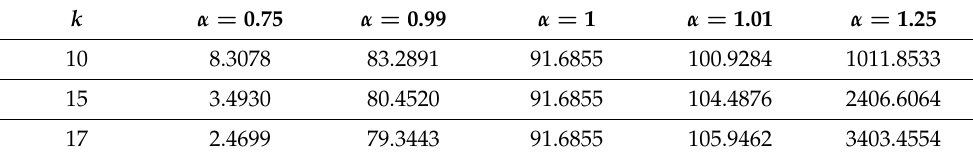
Table 3. Estimations of the C constant in the condition for Hölder continuity with exponent α for approximations of the limit function with k levels of subdivision for initial data coming from 20 point values of the function g ( x ) at the grid X 2 of non-equally spaced